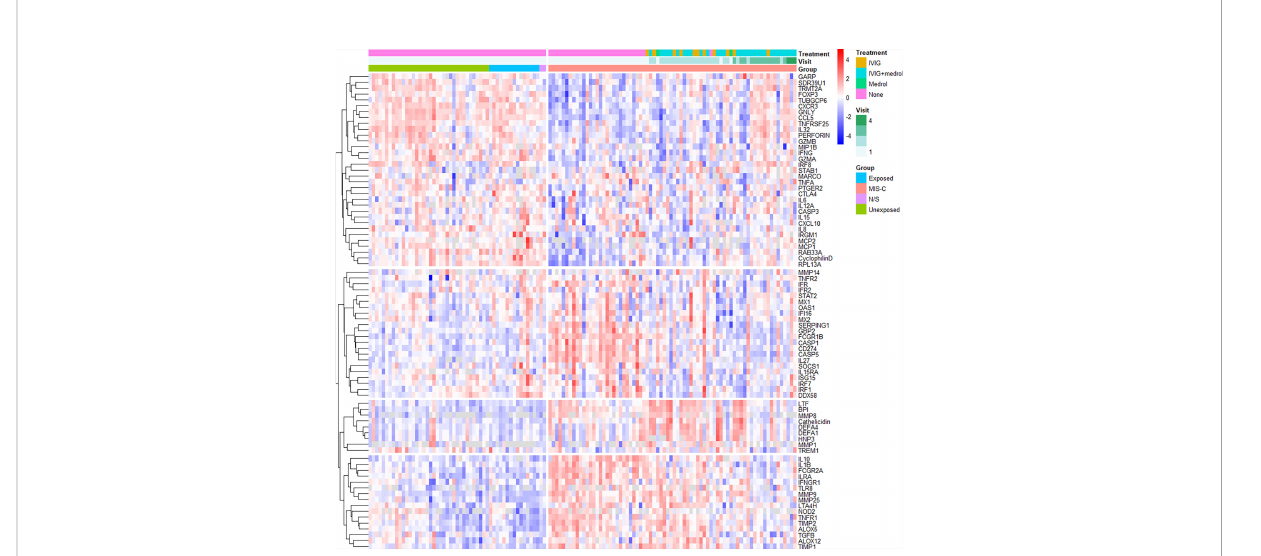
FIGURE 2 Unsupervised hierarchical clustering of gene expression. Samples are grouped by type (MIS-C, SARS-CoV-2 exposed or unexposed healthy controls or healthy controls for whom SARS-CoV-2 exposure was not stated [N/S]) and longitudinally in the case of MIS-C (up to three follow- up visits). The hierarchical tree is cut into four distinct clades: group 1 (top-most), genes that appeared down-regulated compared to controls at baseline; group 2 (second from top), genes that were up-regulated but quickly returned to normal after treatment; group 3 (second from bottom), genes that appeared to be induced by treatment; and group 4 (bottom-most), up-regulated genes that slowly returned to normal over the study period. Healthy controls include those with no recorded exposure to SARS-CoV-2 (unexposed), those with recorded exposure (exposed), and uncertain exposure (N/S). IVIG – intravenous immunoglobulin; N/S – not stated